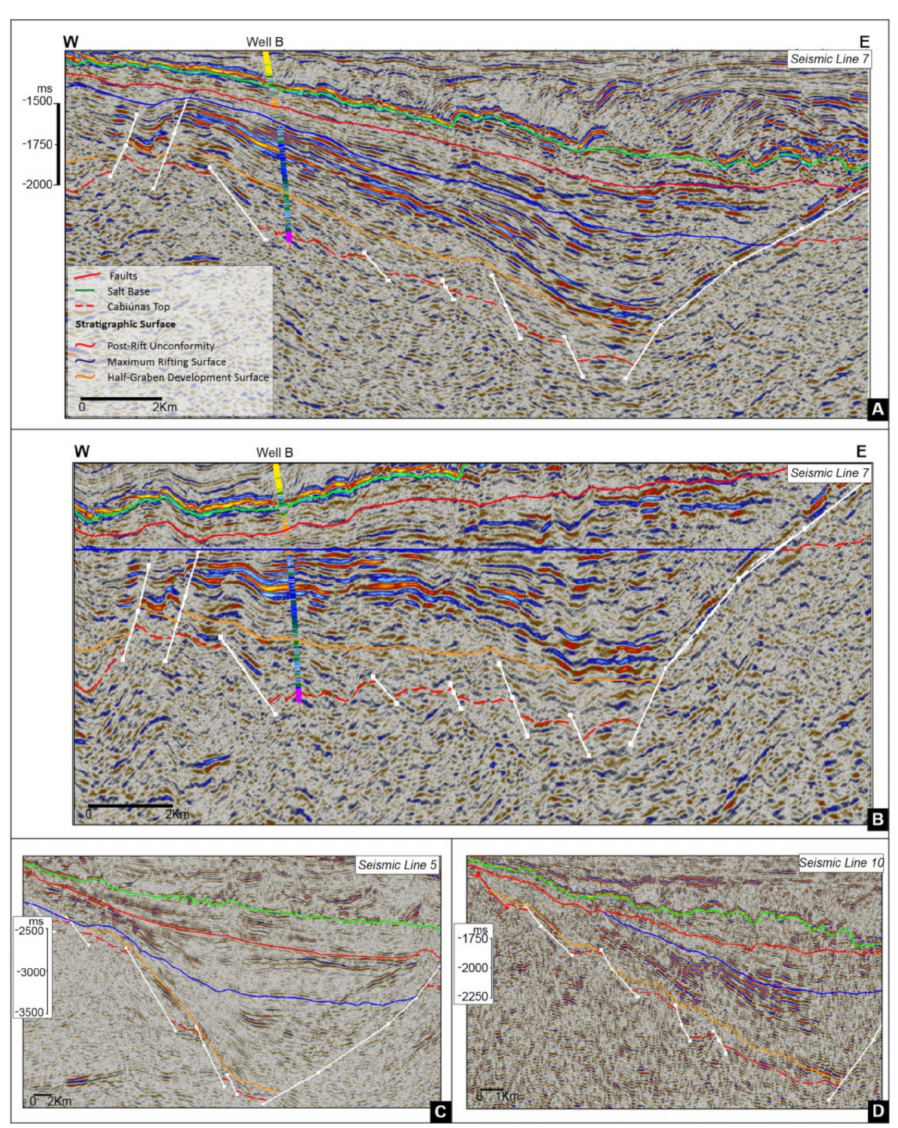
Figure 11. The High Tectonic Activity Systems Tract (HTAST). ( A ) Seismic line 7 shows the divergent pattern of the reflectors in the HTAST (section between orange and blue reflectors). ( B ) Seismic line 7 shows the flattening of the HTAST top (tectonic change surface), highlighting the divergent pattern of HTAST reflectors (section between the orange and blue horizons). ( C ) Seismic line 5 shows the onlap pattern of the HTAST base (onto the orange surface) along the flexural margin. ( D ) Seismic line 10 shows the tectonic change surface, changing from an erosive truncation in the flexural margin to conformity within the